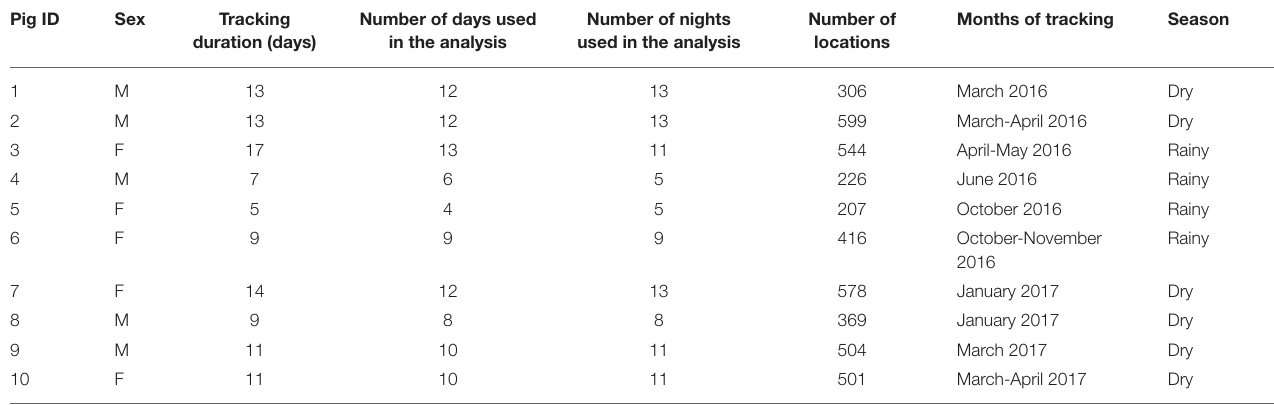
TABLE 1 | Characteristics of the collared